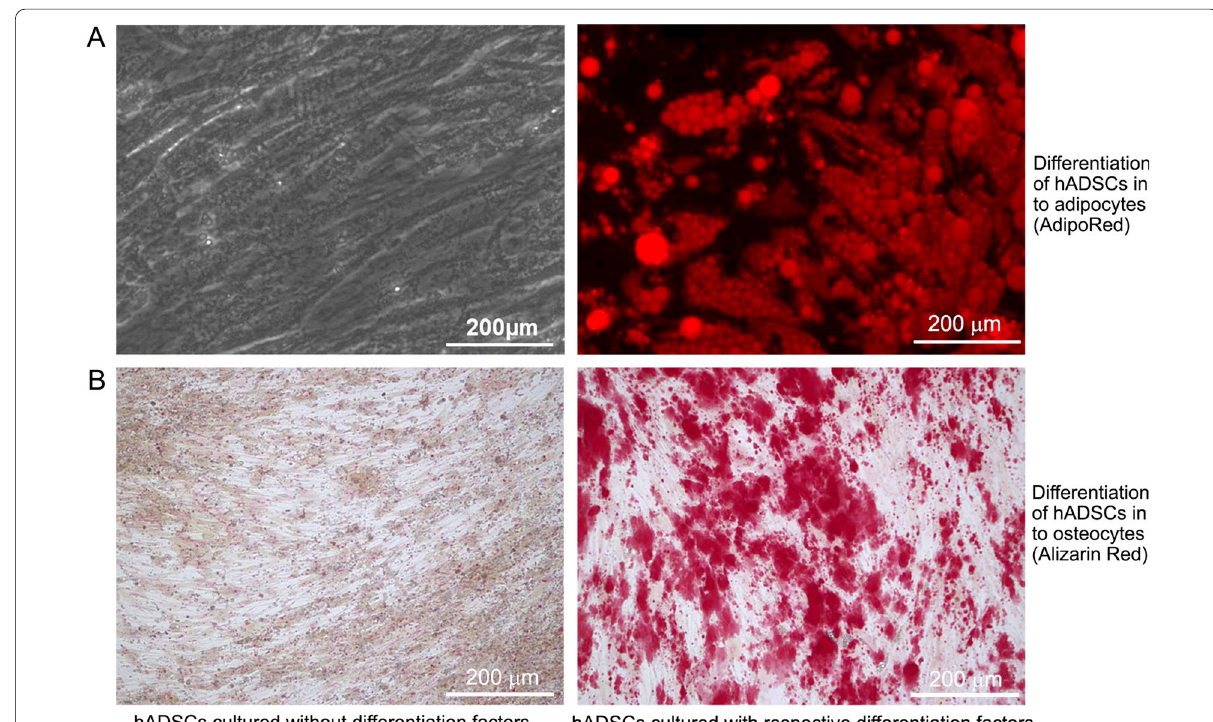
Fig. 2 Differentiation of hADSCs into adipocytes and osteocytes. The hADSCs were cultured with respective differentiation medium for 17 days. A hADSCs cultured with and without adipogneic differentiation factors and stained with AdipoRed. B hADSCs cultured with and without osteogenic differentiation factors and stained with Alizarin Red. Original magnification, ×